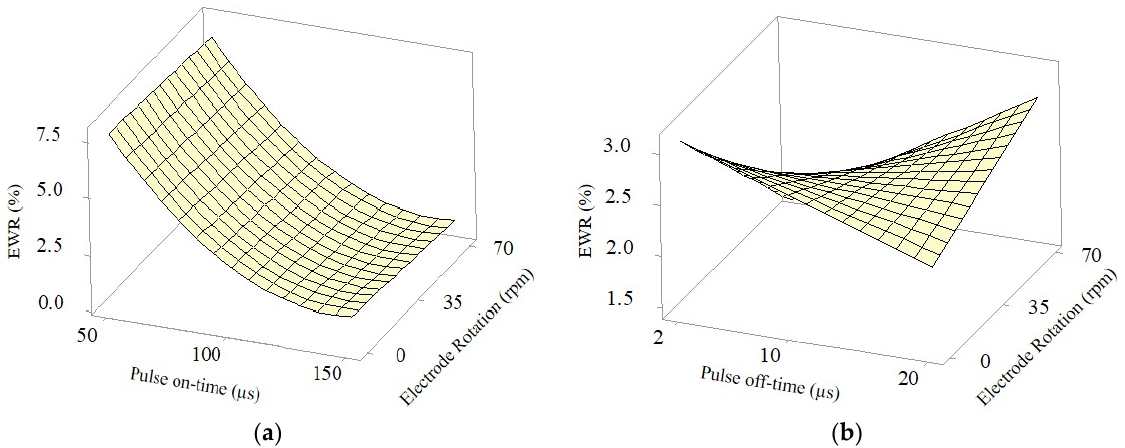
Figure 8. EWR mf as a function of ( a ) pulse on-time and electrode rotation, given pulse off-time = 10 µs and current 12 A, ( b ) pulse off-time and electrode rotation, given pulse on-time = 100 µs and current = 12 A.